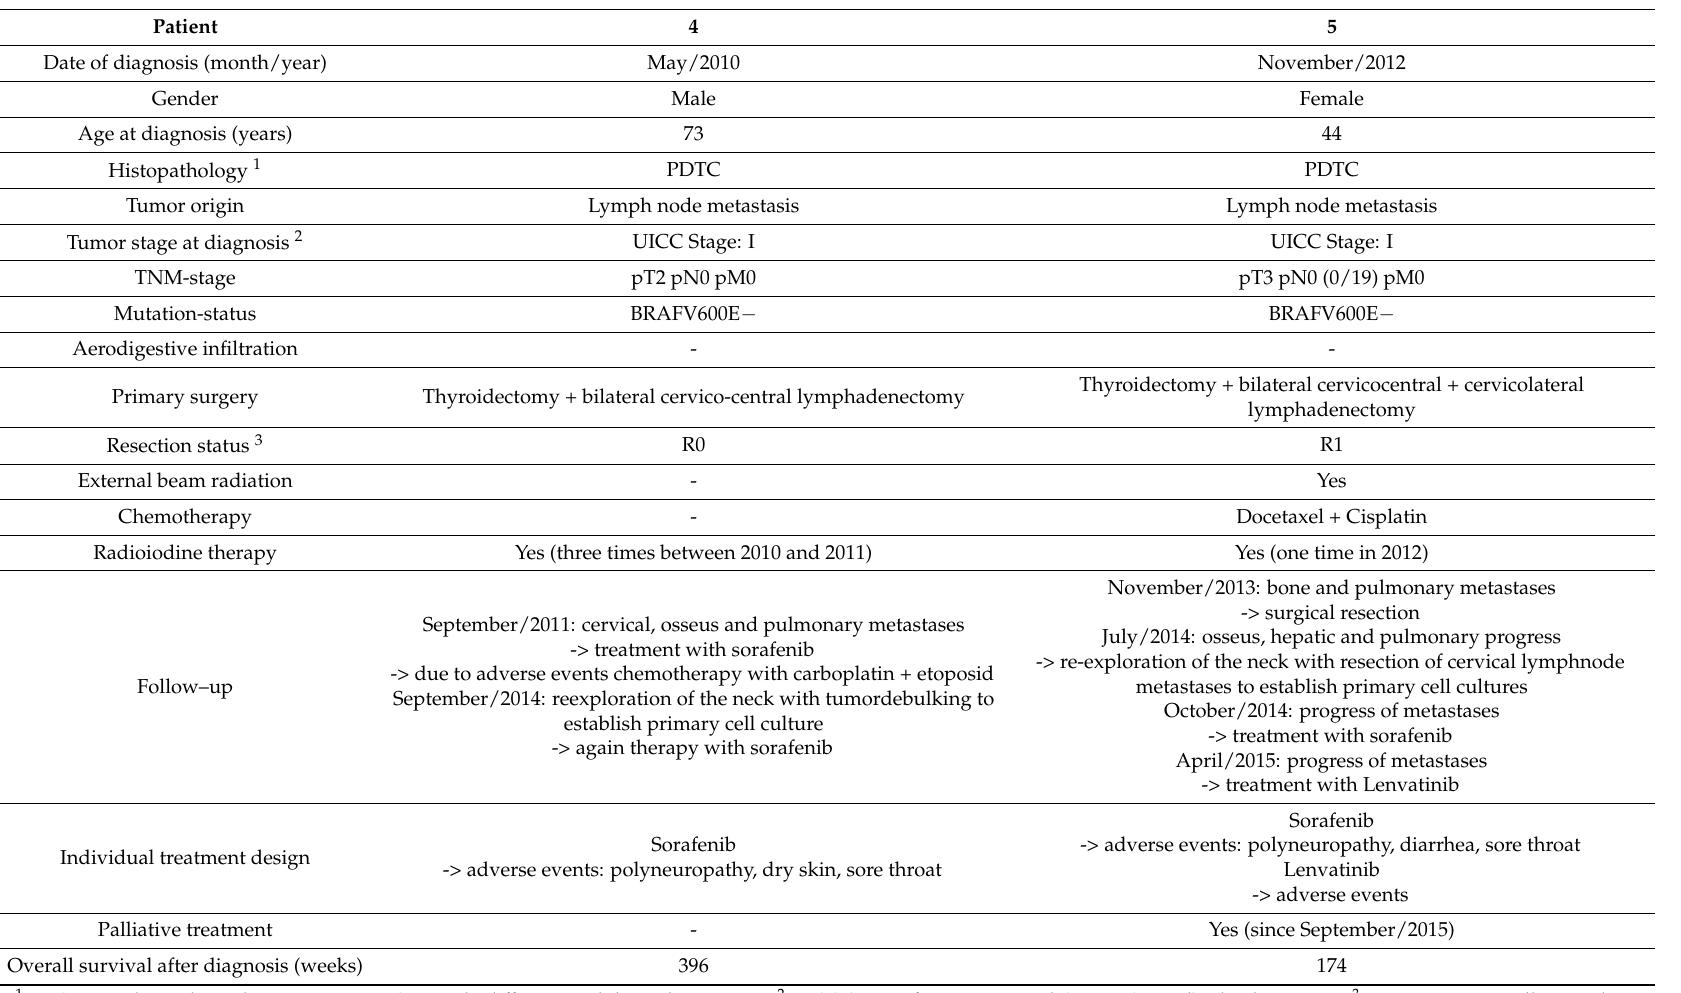
Table 2. PDTC patients characterization based on clinical data collected from tumor board and histopathological